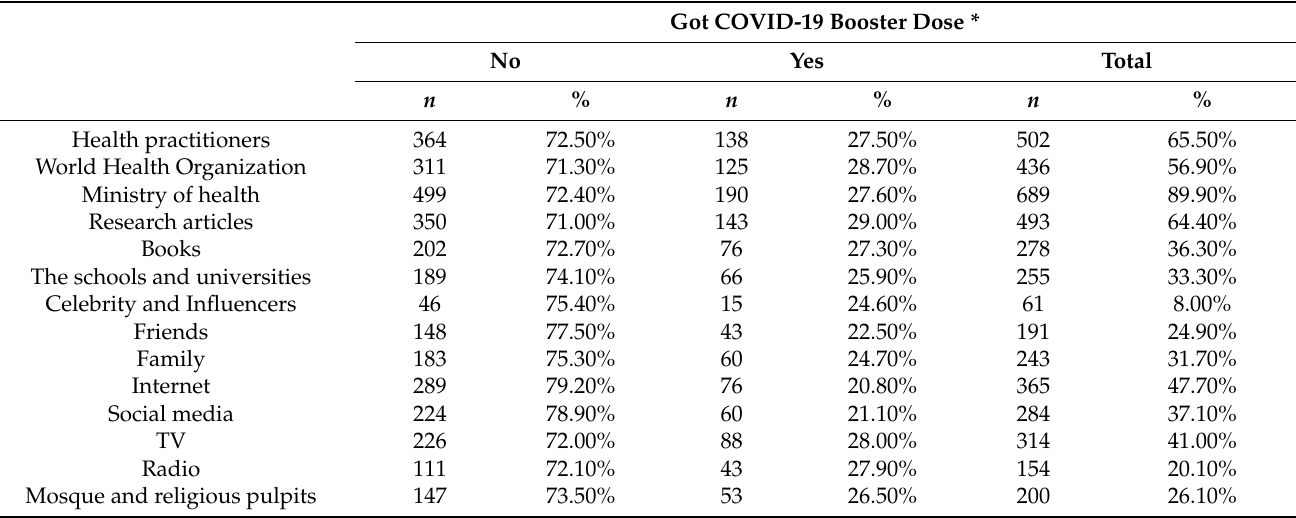
Table 6. Source of information related to COVID-19 and booster dose among study